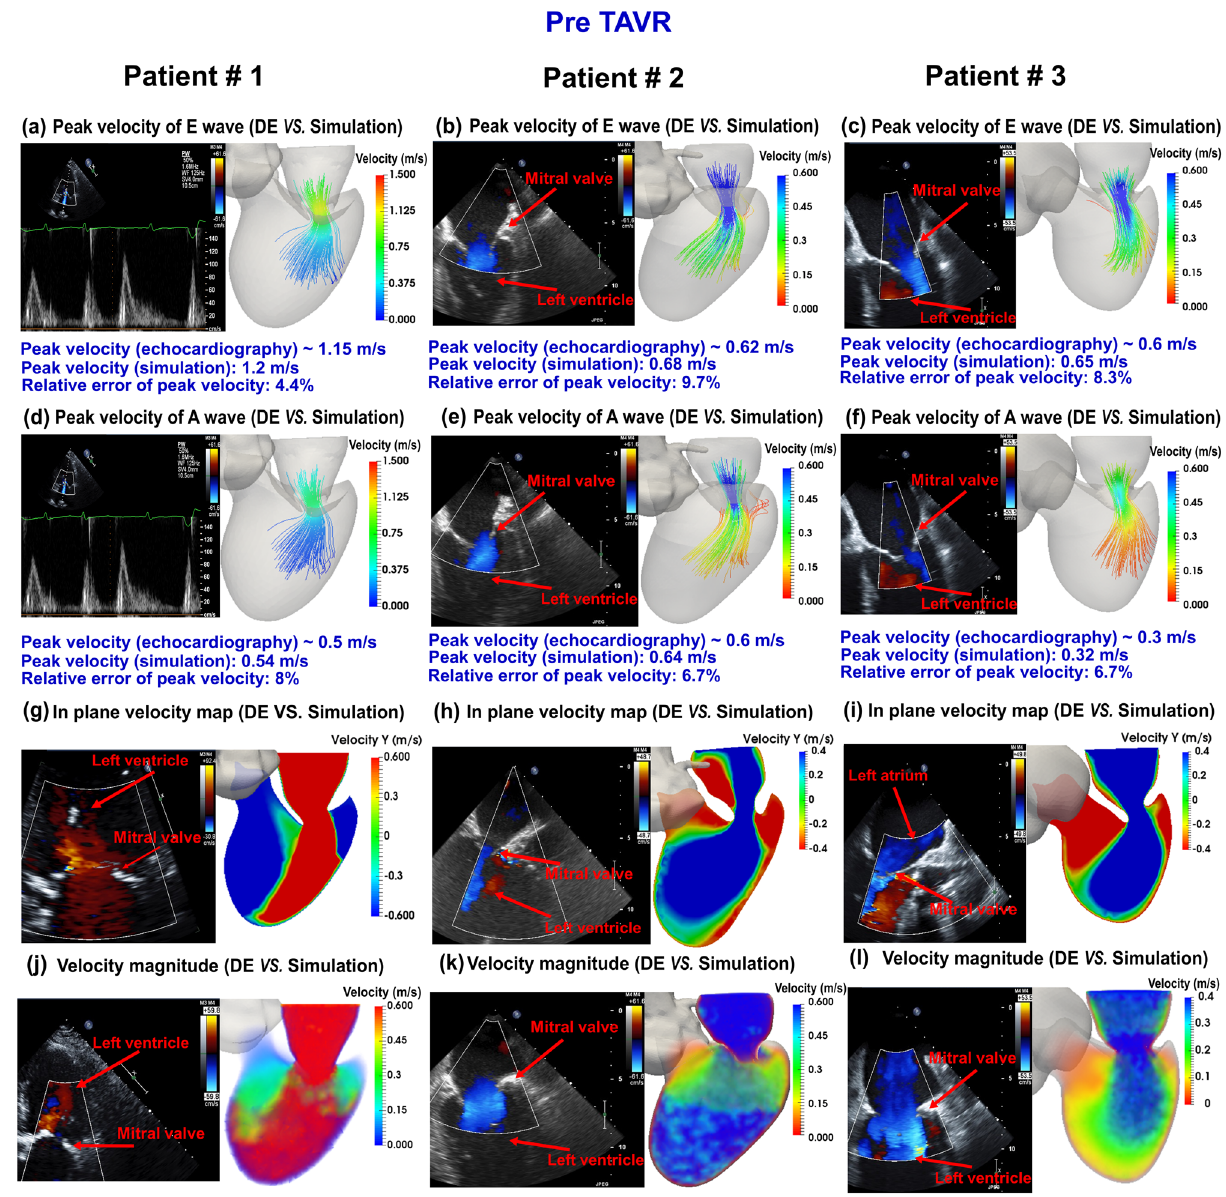
Figure 3. Validation : Doppler-based LPM and FSI framework vs. clinical Doppler echocardiography data in pre-TAVR condition. ( a – f ) Trans-mitral velocity during diastole in patients #1 to #3; ( g – i ) Left ventricle flow (apical view) during diastole in patients #1 to #3; ( j – l ) Trans-mitral and left ventricle flow (apical view) in patients #1 to